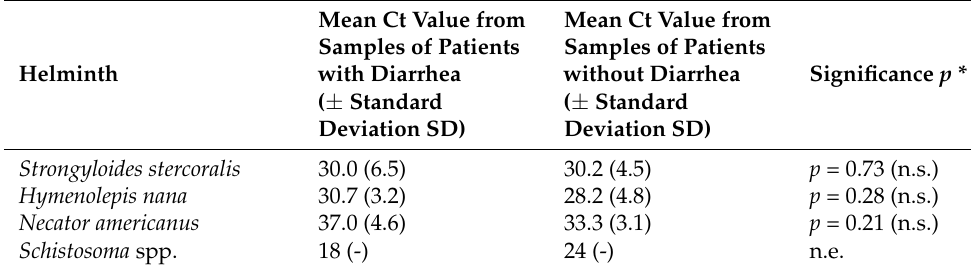
Table 2. Ct values in case of helminth infections in patients with and without reported diarrhea. Helminth Strongyloides stercoralis 30.0 (6.5) 30.2 (4.5) p = 0.73 (n.s.)